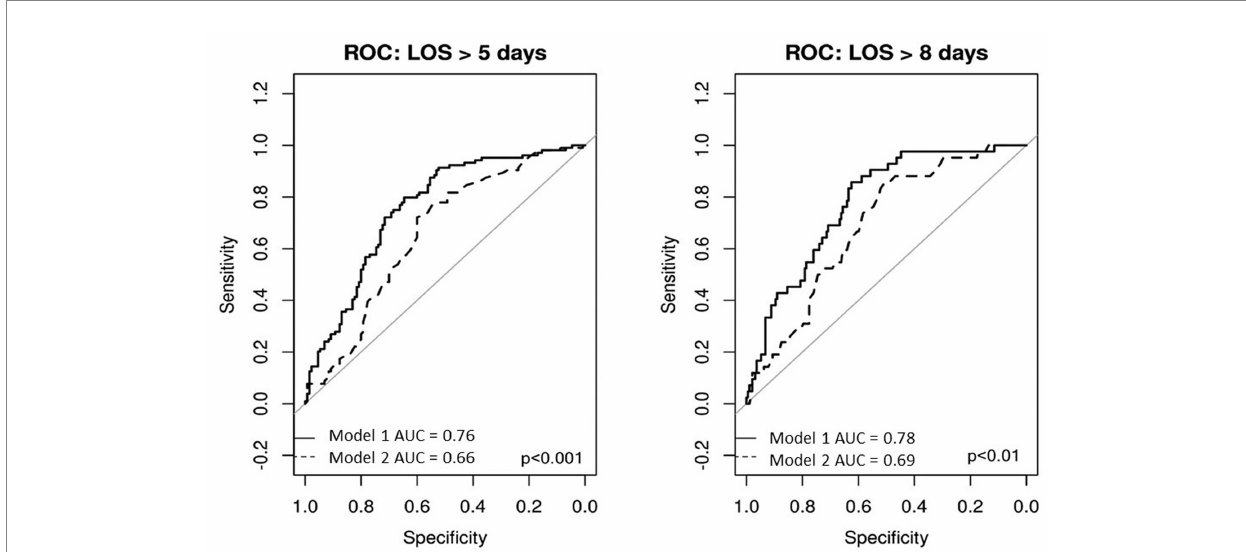
FIGURE A1 Receiver operating characteristic (ROC) curve accuracy of the models to predict 5 days and 8 days length of hospital stay. For both 5 days and 8 days prediction, model 1 showed higher accuracy than model 2. Model 1 includes the following variables: pulmonary embolism severity index (PESI) score, body mass index (BMI), a medical history of dyslipidemia, diabetes or previous PE, NT-proBNP and troponin-T hs, housing situation before admission and admission via GP. Model 2 only includes the PESI score. Pulmonary embolism severity index score is based age at entry, sex, history of